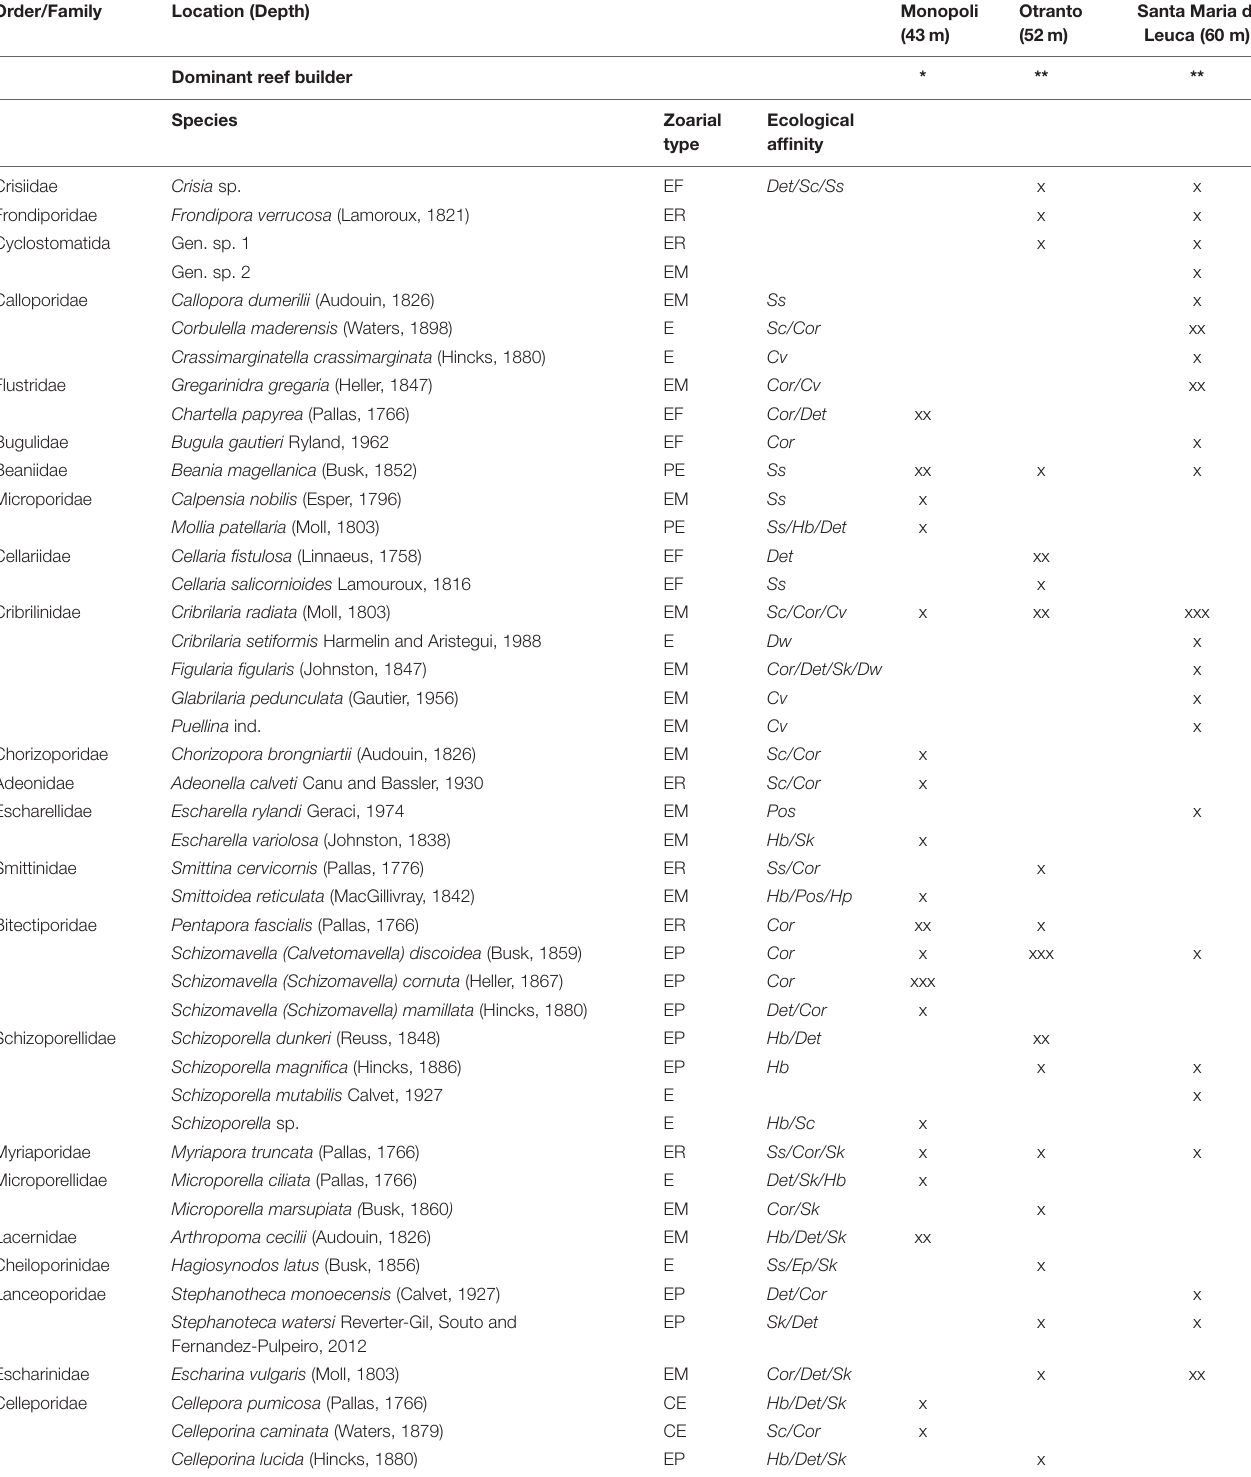
TABLE 1 | List of the bryozoan species and their percentage coverage (x = < 10%, xx = 10%–50%, xxx = > 50%) in each site. Order/Family Location